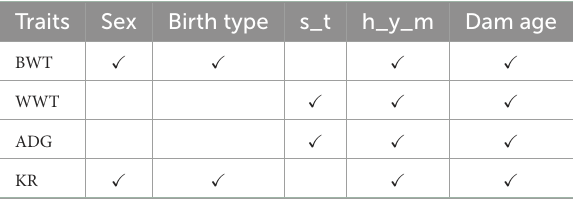
TABLE 3 The fixed effects used in the models for traits. Traits